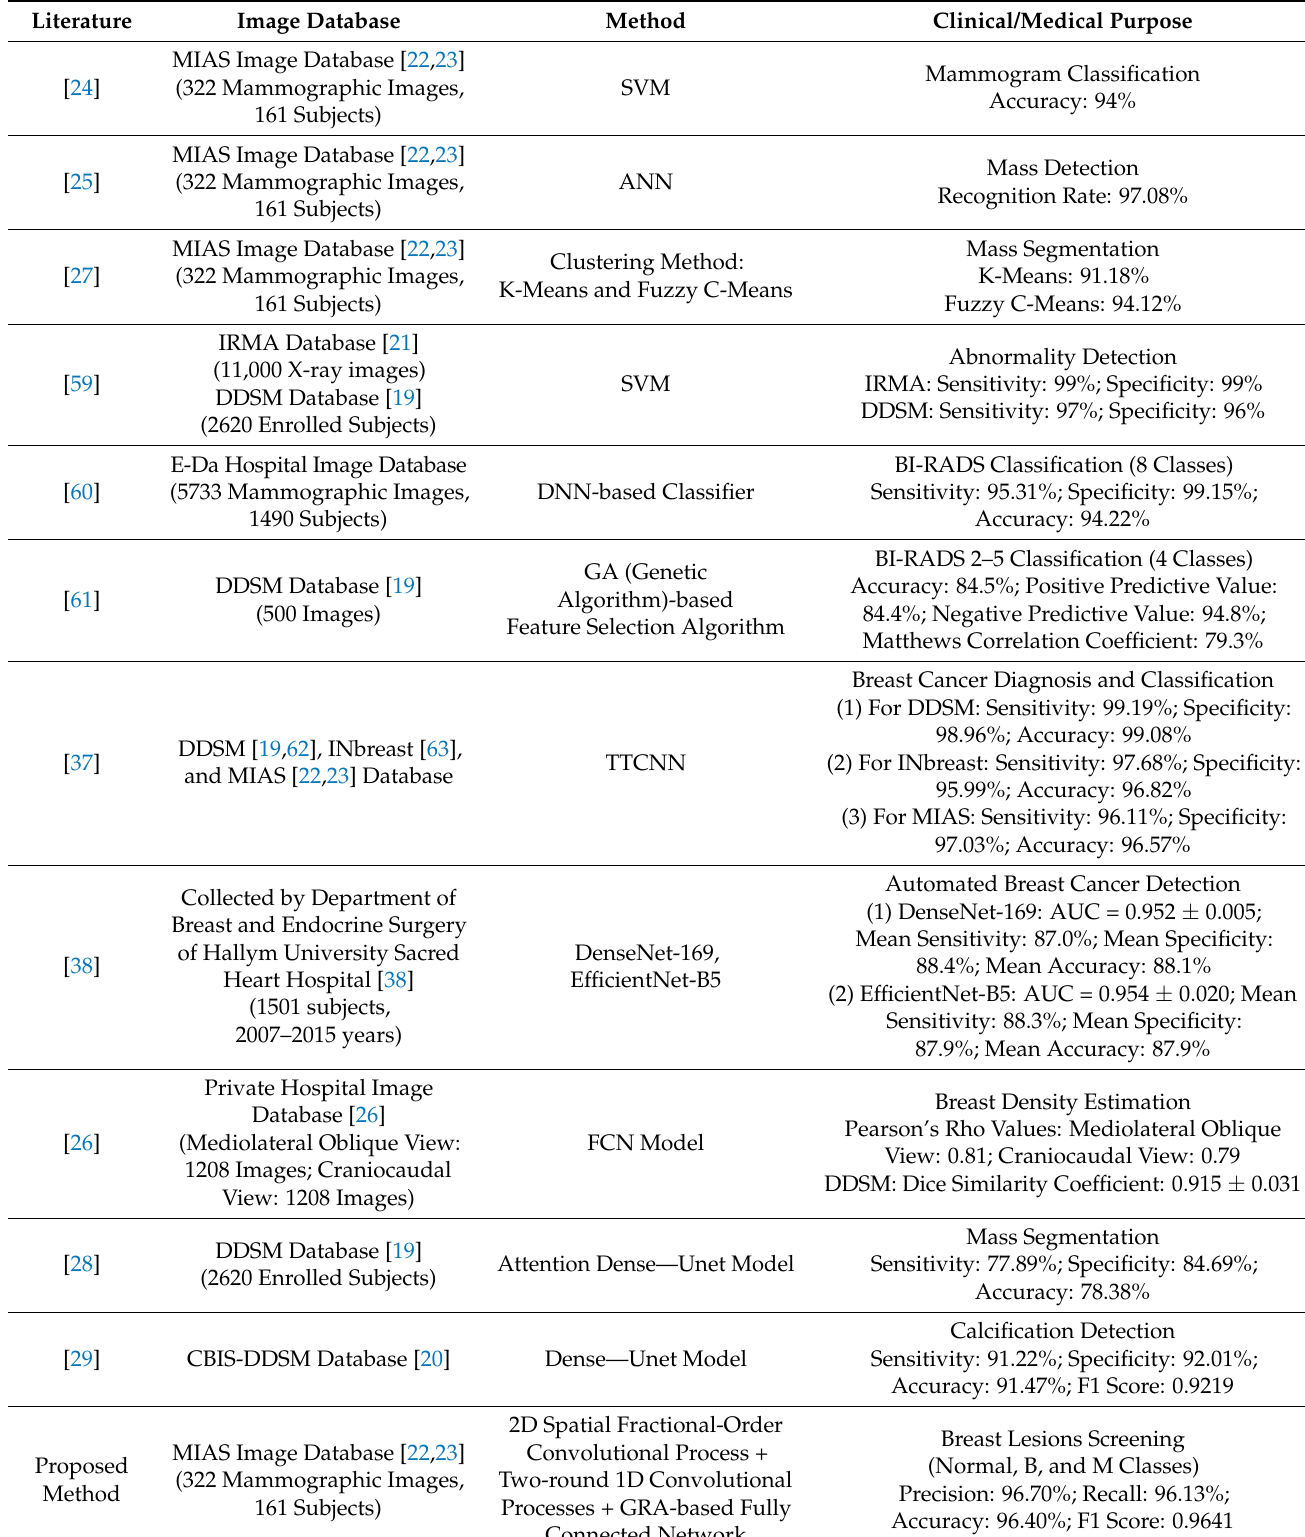
Table 5. Comparison of the cardiomegaly level screening